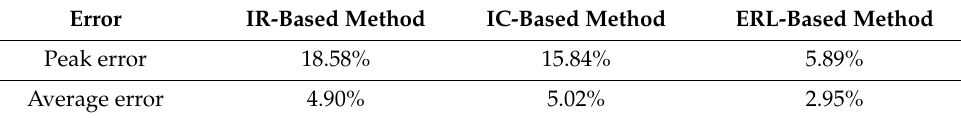
Figure 8. Comparison of lifetime estimation. ( a ) average error ( b ) peak error. Table 3. Error of lifetime estimation.